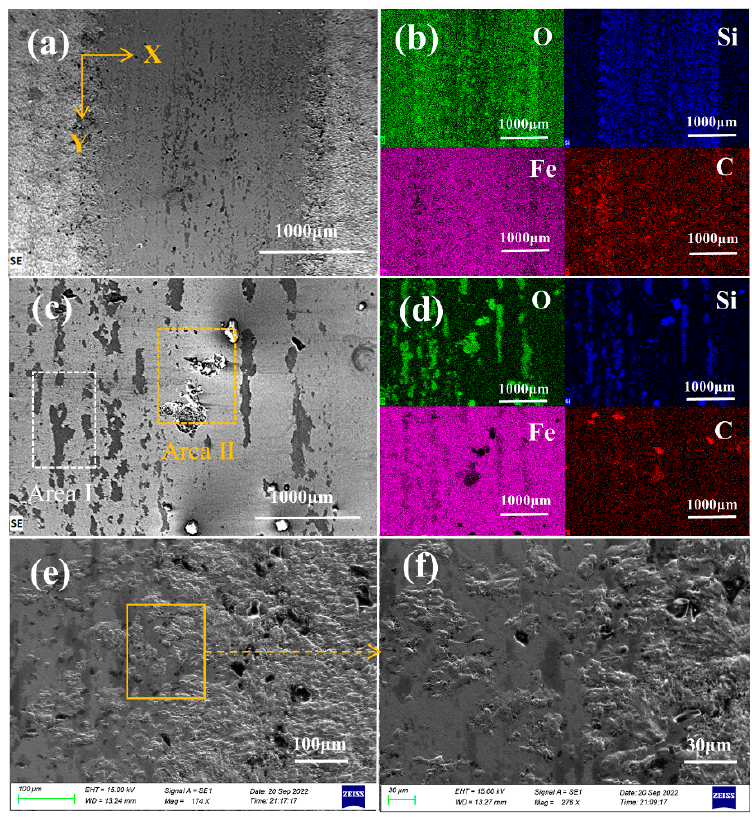
Figure 10. SEM and EDS morphologies after Micro-LSP treatments of 150 mJ ( a – b ), middle of the abrasion ( c – d ), and central abrasion abraded edges ( e – f ).